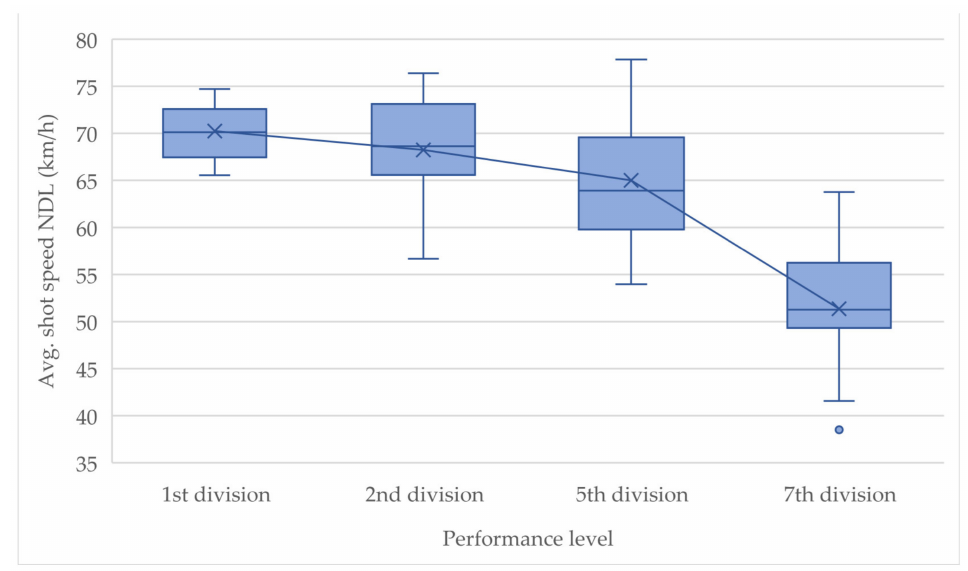
Figure 4. Boxplots of avg. shot speed NDL by performance